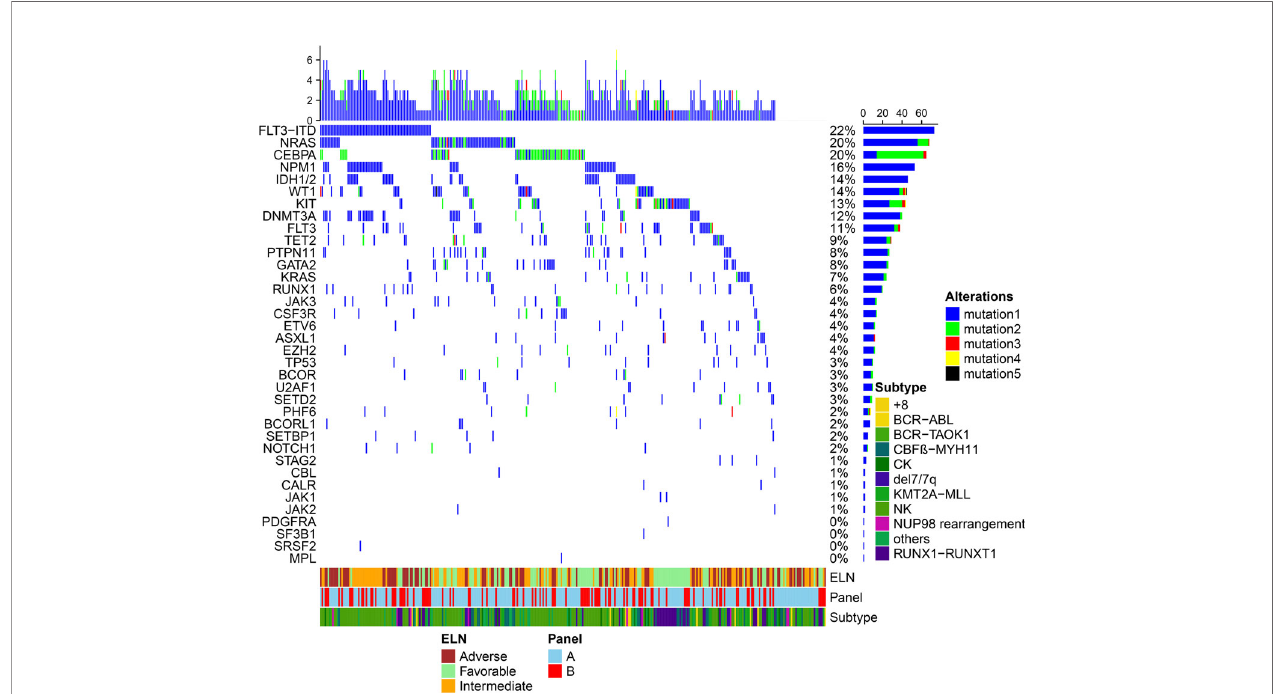
FIGURE 1 | Mutation patterns observed in 332 acute myeloid leukemia patients who were treated with allogeneic hematopoietic stem cell transplantation. (A) indicates that 225 samples were performed using the Illumina HiSeq Sequencing platform in Nanjing Shihe Jiyin Biotech Inc. Laboratory. (B) indicates that 107 samples were performed by the Ion S5 system (Personal Genome Machine, Thermo Fisher, Grand Island, NY, USA) in our own experimental platform. The plot represents a graphical summary of the distribution of somatic lesions in sequenced genes across the set of patients. Columns represent samples, and rows represent genes. European LeukemiaNet (ELN) risk classi fi cation and subtype of chromosome were summarized on the bottom. (The eight mutations consisting of BIRC3 , BRAF , CDKN2A , IL7R , MYD88 , PAX5 , PDGFRB , and PTEN were not detected in both groups of samples and were not included in the